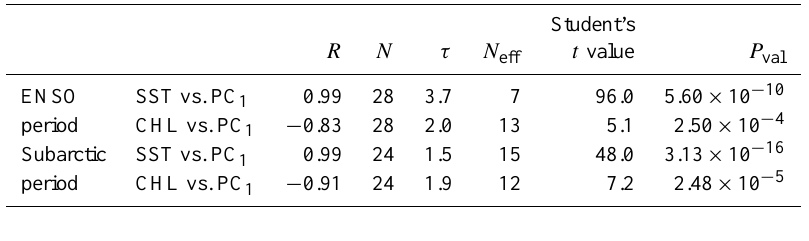
Table 2. Correlations between N monthly SST and Chl a time series of the data and its corresponding principal components of individual EOF analyses for two subsets: ENSO period (September 1997–December 1999) and Subarctic period (January 2002 and December 2003) along with τ the integral timescale, N eff the effective degree of freedom, Student’s t value and P val the statistical significance. Correlation significance levels were obtained consulting classical statistical tables and using the methodology proposed by Davis (1976) and Tren- berth (1983).